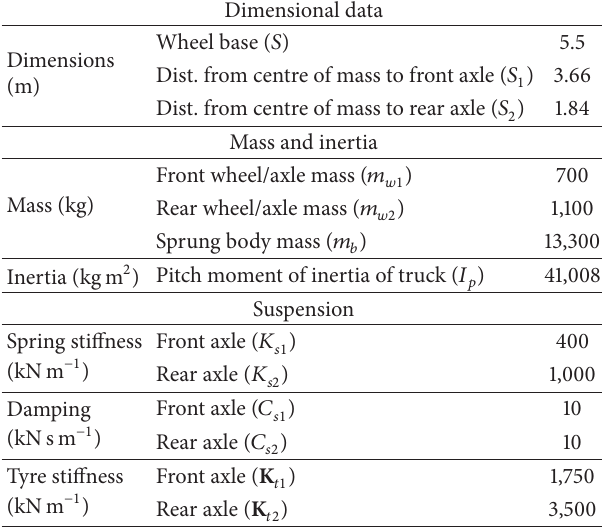
Table 1: Typical parameters for truck model. Dimensional